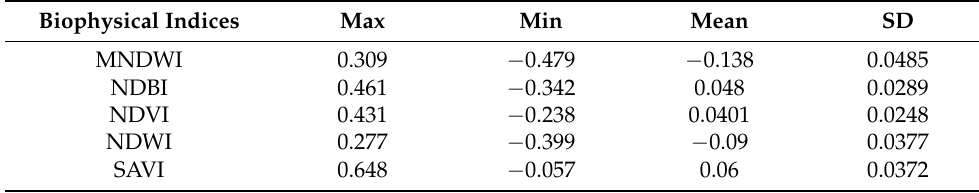
Table 3. Descriptive statistics of the biophysical